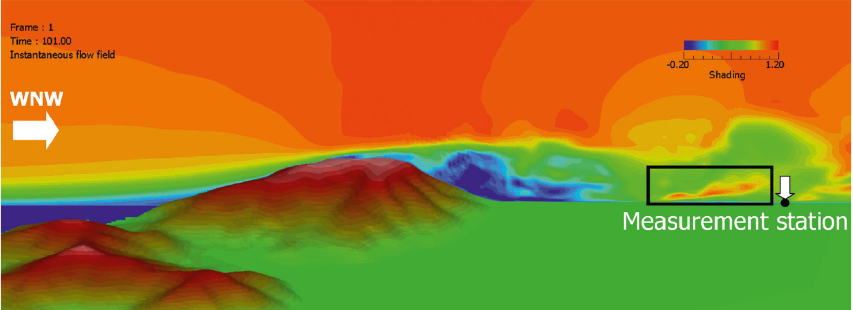
Figure 8: Wind speed distribution in the mainstream direction x , instantaneous flow field, and vertical cross section passing through the observation mast.